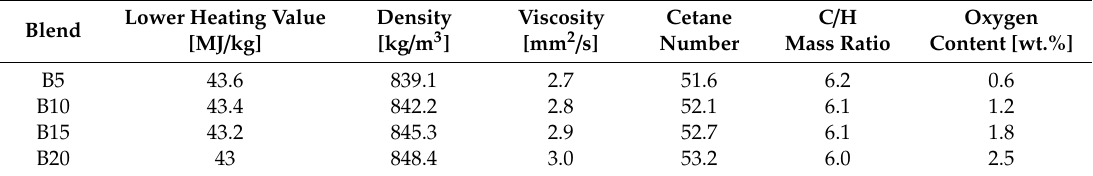
Table 7. Properties of DSO biodiesel blends.